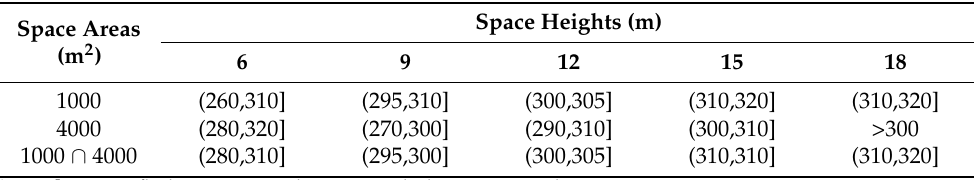
Figure 12. Pectin-PEGMA solution turned white after the addition of α -CD: ( a ) original 10% P-10K solution; and ( b ) 10% P-10K solution after the addition of α -CD (10%).